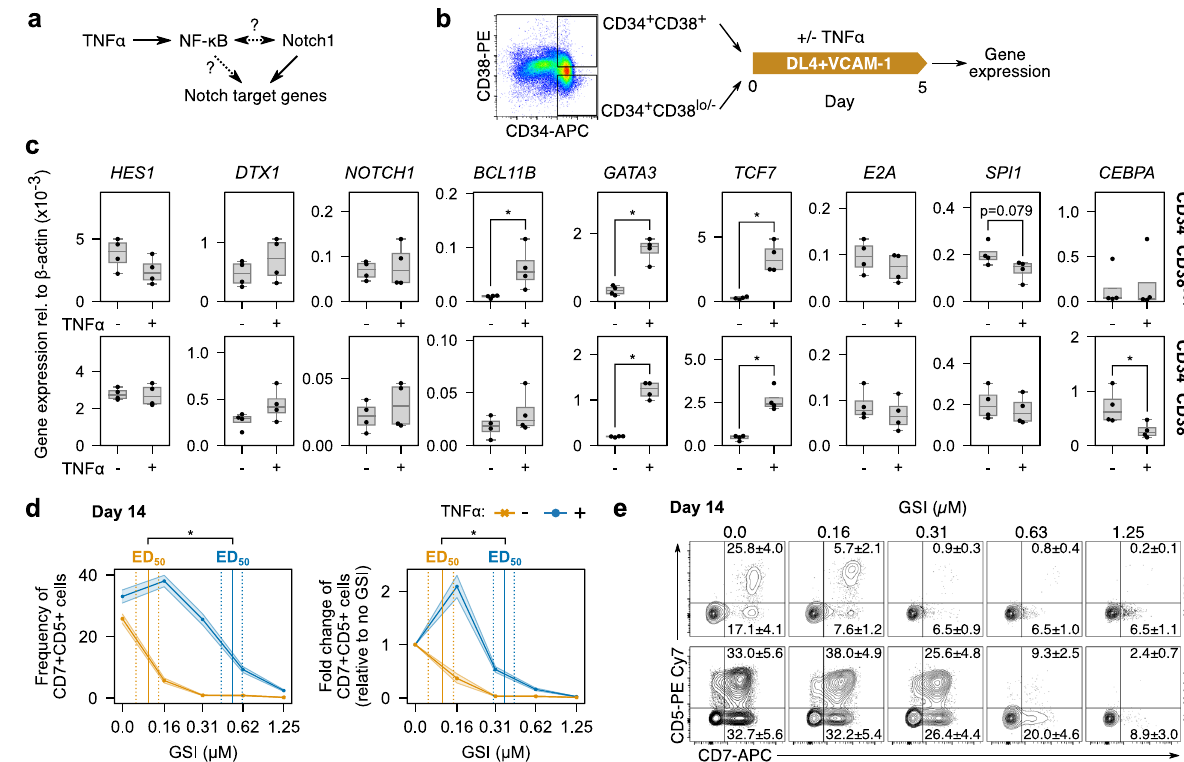
Fig. 2 Synergy between TNF α and the Notch pathway compensates for low Notch activation. a TNF α activates the NF- κ B pathway, which may regulate Notch target genes or regulate Notch itself. b To investigate the ways that TNF α may be interacting with Notch, CD34 + HSPCs were sorted into CD38 lo/ − and CD38 + fractions and seeded separately on DL4 + VCAM-1 with and without TNF α . Gene expression was measured using qPCR after 5 days of culture. c Both the CD38 lo/ − and CD38 + fractions upregulated GATA3 and TCF7 in response to TNF α while only CD38 lo/ − HSPCs upregulated BCL11B . No differences were observed in any other Notch target genes, implying that TNF α is not regulating Notch itself. CD38 lo/ − but not CD38 + HSPCs downregulated SPI1 slightly in response to TNF α . In contrast, only the CD38 + fraction signi fi cantly downregulated CEBPA when cultured with TNF α . Bar plots show a median and interquartile range of n = 4 independent UCB donors. d CD34 + HSPCs were seeded on DL4 + VCAM-1 for 14 days with increasing concentrations of γ -secretase inhibitor (GSI) to inhibit Notch activation. TNF α was able to maintain CD7 + CD5 + cell generation with a signi fi cantly higher concentration of GSI than without. e Representative fl ow cytometry plots show the differential effects of Notch inhibition with and without TNF α . d , e are mean ± standard error from n = 7 independent UCB donors and * p <